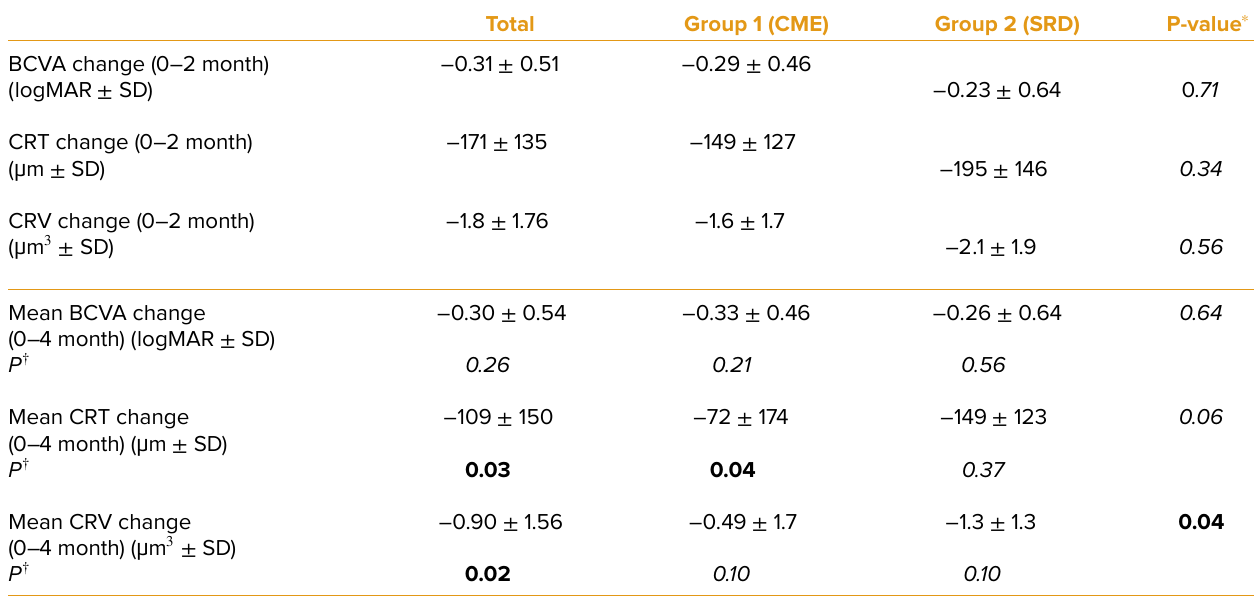
Table 3. The mean change of BCVA, CRT, and CRV over four months. Total Group 1 (CME)